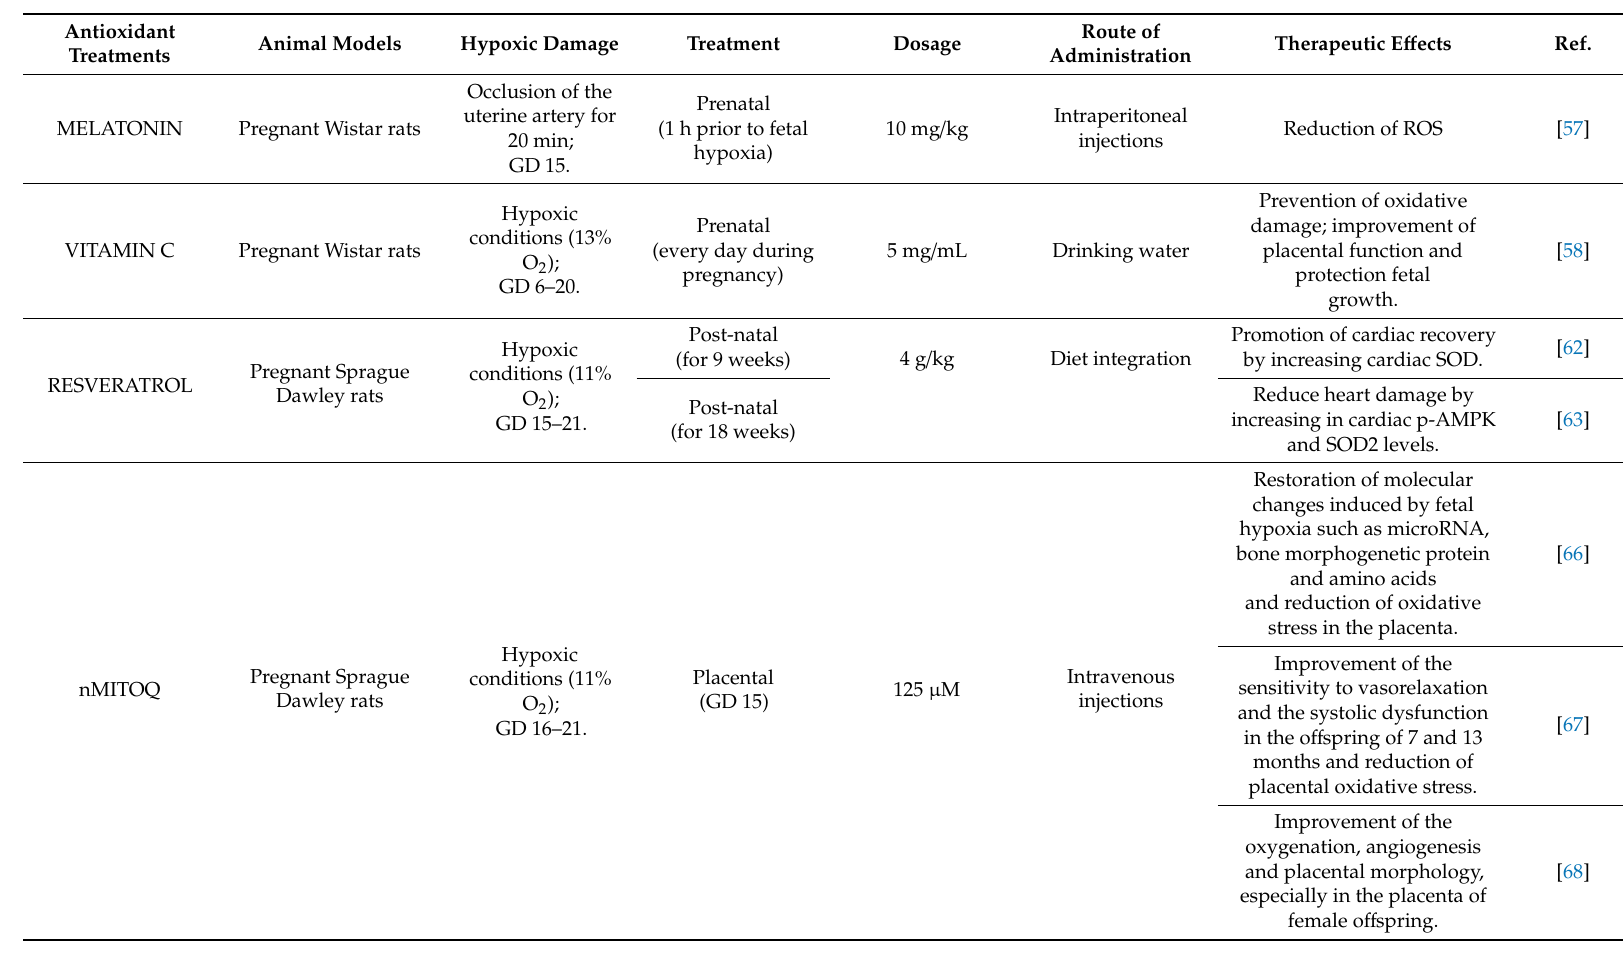
Table 2. Synthesis of the studies aimed at testing the antioxidant properties of some substances such as melatonin, vitamin C, resveratrol, nMitoQ, hydrogen and erythropoietin. Specifically, the table shows the animal models used in the studies and the type of hypoxic damage induced. Additionally, the type of treatment, the dosage, the route of administration and the therapeutic e ff ects obtained are